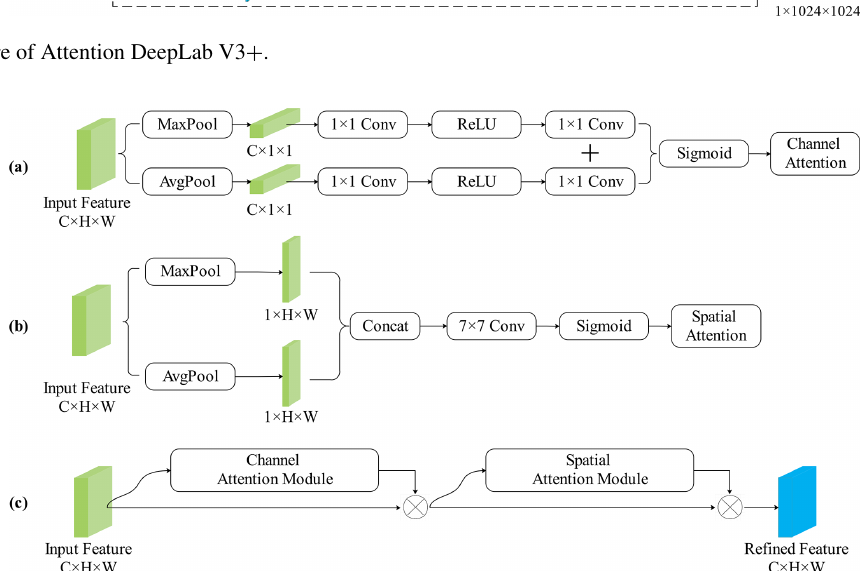
Figure 3. Attention module. (a–c) Channel attention module, spatial attention module and CBAM,